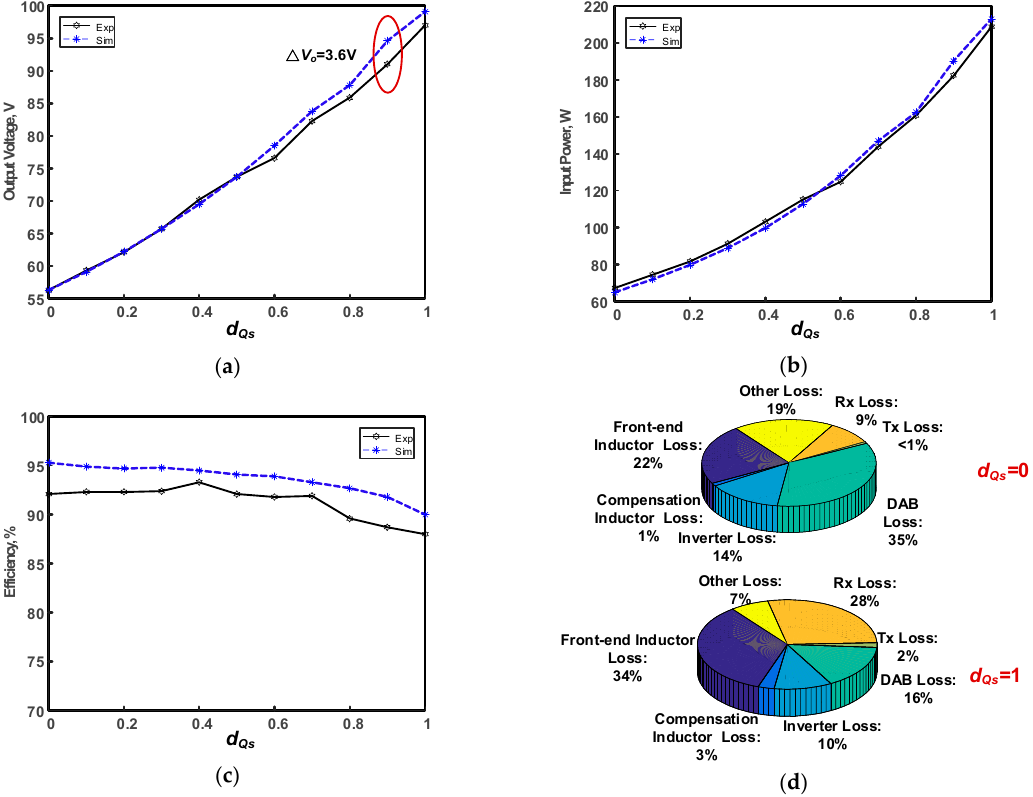
Figure 18. Efficiency and power loss comparison ( a ) V o vs. d Qs ; ( b ) P i vs. d Qs ; ( c ) η vs. d Qs ; ( d ) loss analysis of extreme working cases.